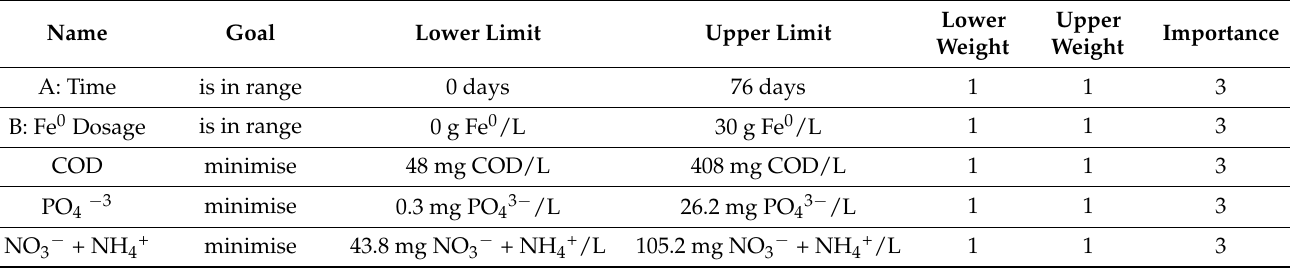
Table 4. Set of constraints for optimisation of the objective